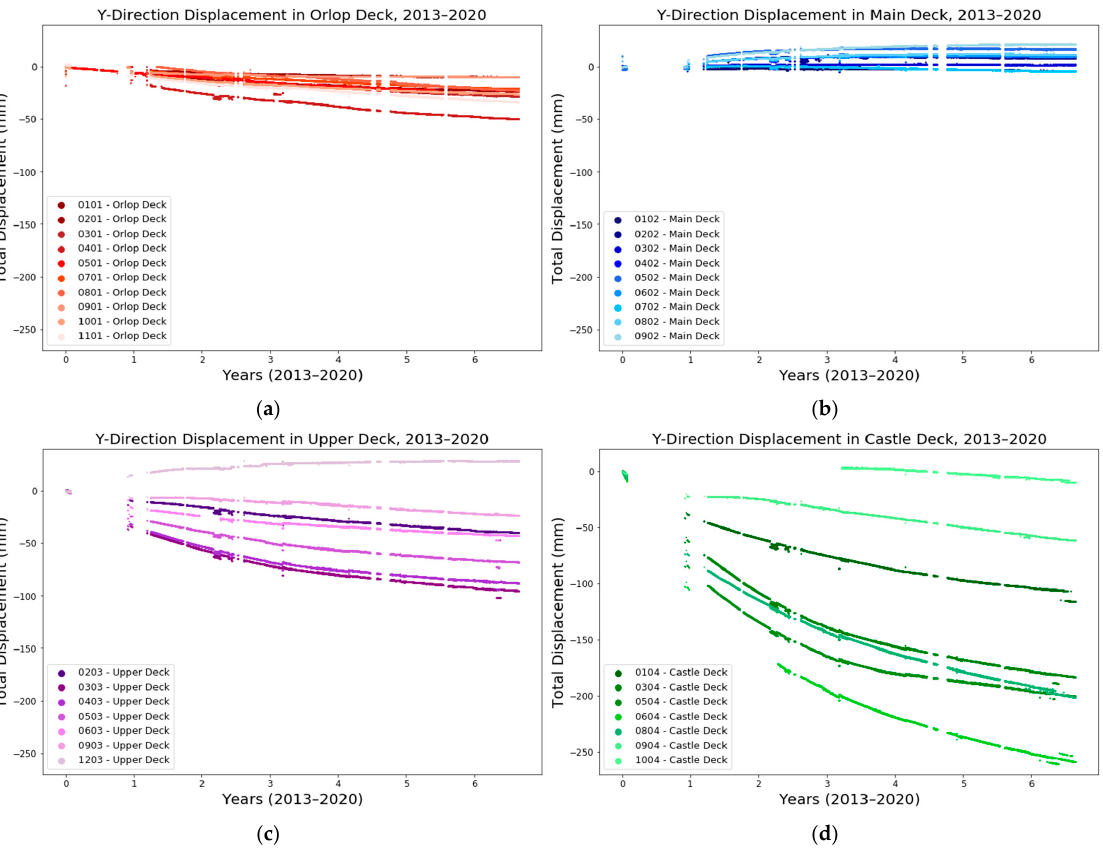
Figure 4. Y direction displacement of the TS targets in the ( a ) orlop, ( b ) main, ( c ) upper and ( d ) castle decks plotted against time for the period between September 2013 and March 2020.